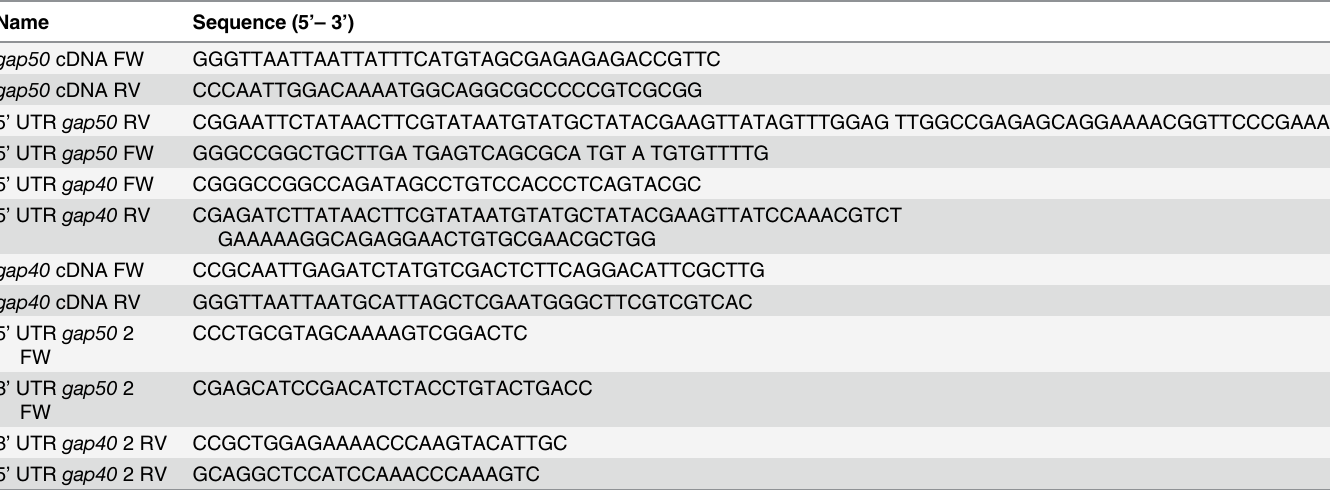
Table 1. List of oligonucleotides used in this